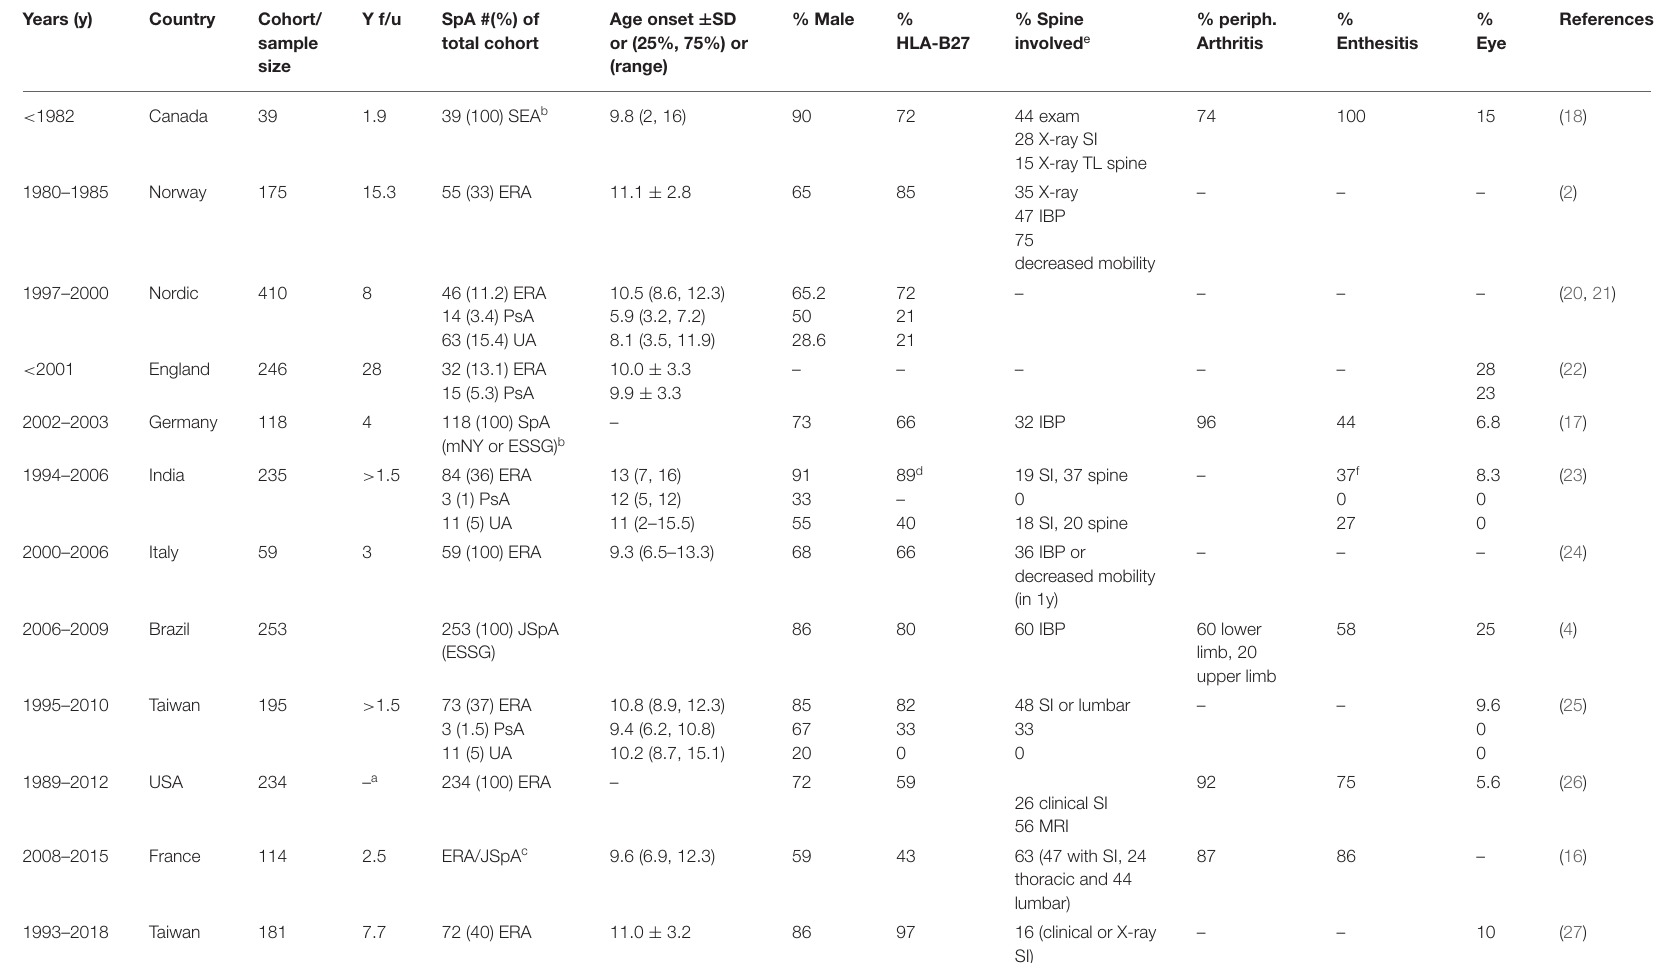
TABLE 1 | JoSpA/ERA clinical